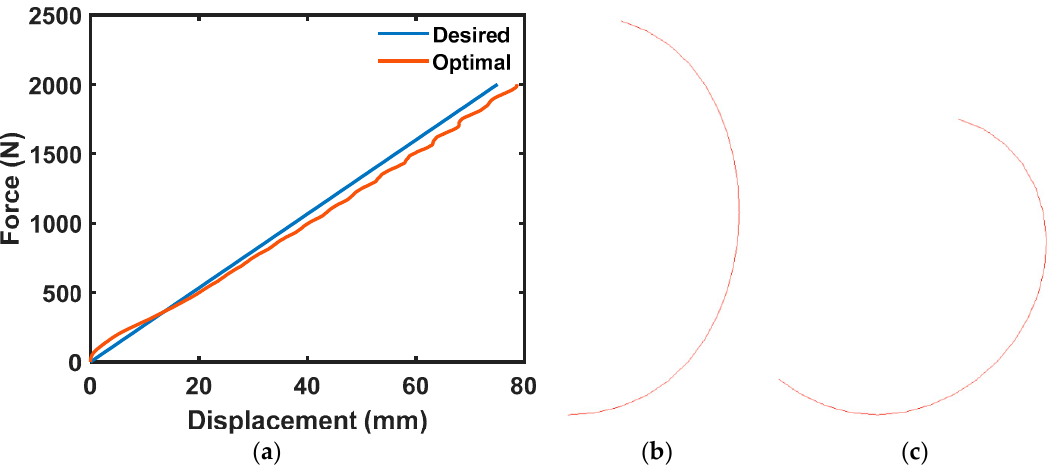
Figure 4. ( a ) Force-displacement characteristics of the prosthesis with linear characteristics. ( b ) Initial shape of the optimized prosthesis with linear characteristics. ( c ) Deformed shape of the optimized prosthesis with linear characteristics under force 2000 N.